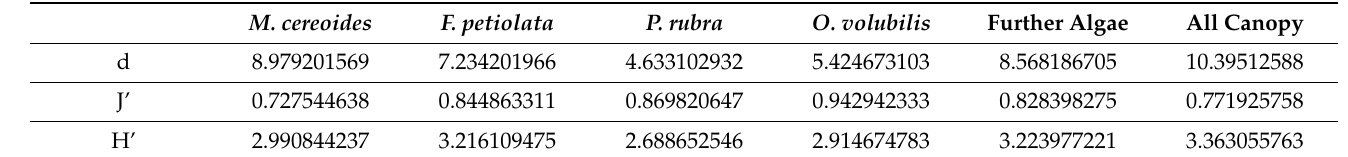
Table 5. Margalef (d), Pielou (J’) and Shannon (H’) indexes for bryozoan and serpulid living as- semblages found on the bryozoan Margaretta cereoides and on algae of the canopy of the build-up E collected offshore Marzamemi (Ionian